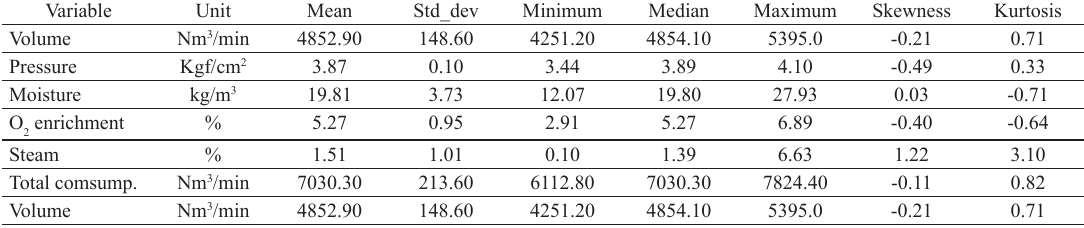
Table 7. Blow air variables.